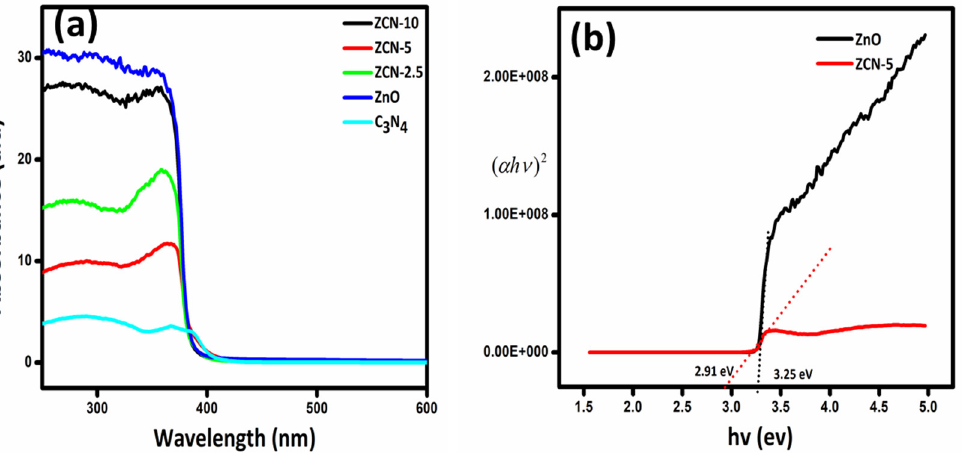
Figure 3. ( a ) UV DRS spectra ZnO and composites of ZnO/C 3 N 4 ; ( b ) Tauc plot of ZnO and composites of ZnO/C 3 N 4 (ZCN-5).